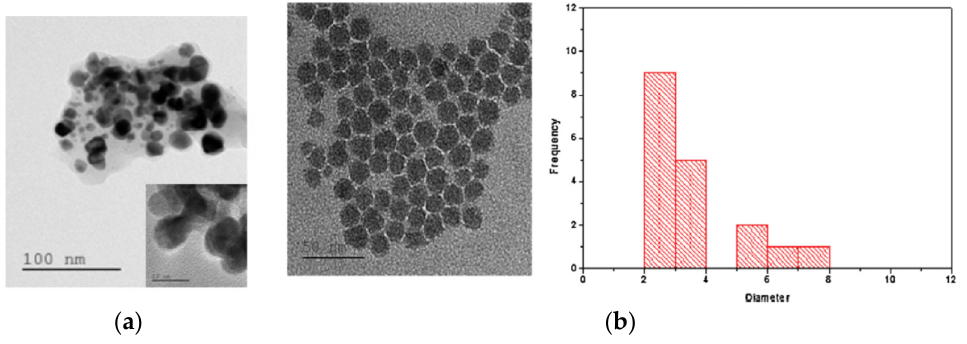
Figure 23 . ( a ) TEM images of Pd NPs deposited on lignin and prepared by Kumar et al.; ( b ) TEM images and size distribution of the same catalysts after the sixth run of Heck reaction [154].